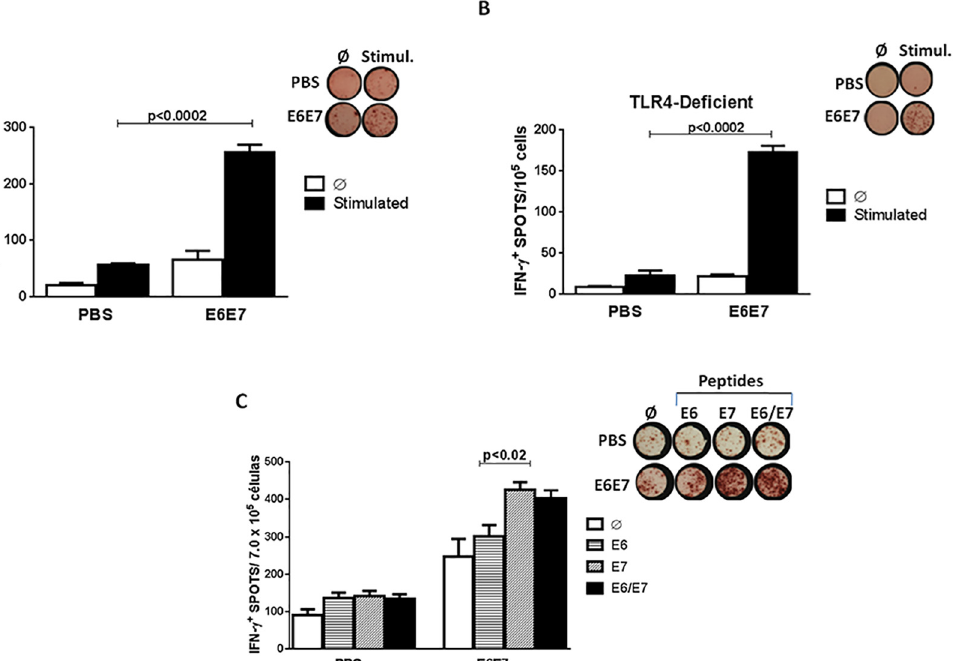
Fig 4. Induction of antigen-specific IFN- γ secretion responses in mice immunized with E6E7. (A) C57BL/6 mice were immunized with three doses of PBS/2M urea (PBS) or E6E7 protein vaccine and challenged with TC-1 tumor cells two w3eeks after the last dose. The ELISPOT assay was performed with PBMC twenty days after the challenge. (B) TLR4 knockout mice were immunized with three doses of PBS/2M urea (PBS) or E6E7 and challenged with TC-1 tumor cells two weeks after the last dose. The ELISPOT assay was performed with PBMC twenty days from the challenge. The cells were stimulated with E6 (VYDFAFRDL 49-57 ; DKKQRFHNI 127-135 ) and E7 (RAHYNIVTF 49-57 ; LCVQSTHVD 67-75 ) peptides. (C) Comparative IFN- γ production between PBMC stimulated with E6 49 - 57 and/or E7 49 - 57 specific peptides (Stimul.); Ø – Unstimulated cells.